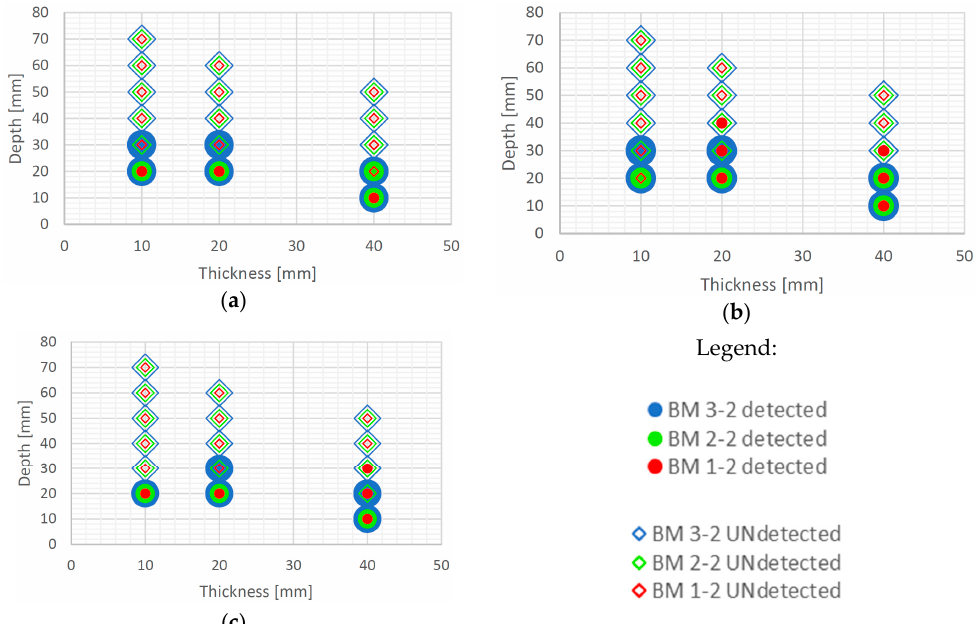
Figure 15. Possibility of defect detection overview for samples BM x-2 (all three concrete types) using optimal thermograms: ( a ) excitation distance 1.5 m; ( b ) excitation distance 2 m; ( c ) excitation distance 3 m.